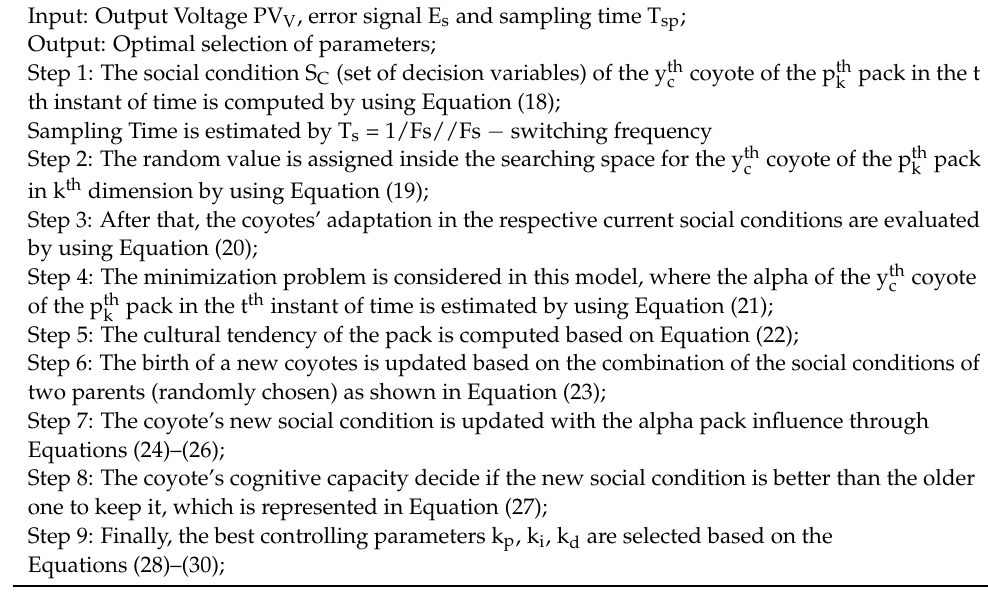
Algorithm 2: Coyote Optimized Converter Control